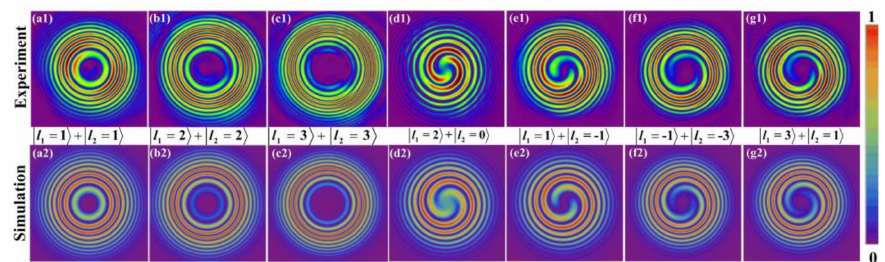
Figure 6. Coaxial interference characteristics between two vortex beams with TCs’ difference of 0 (columns ( a – c )) and 2 (columns ( d – g )). Row 1 shows the experimentally measured interference patterns, and row 2 corresponds to the simulation